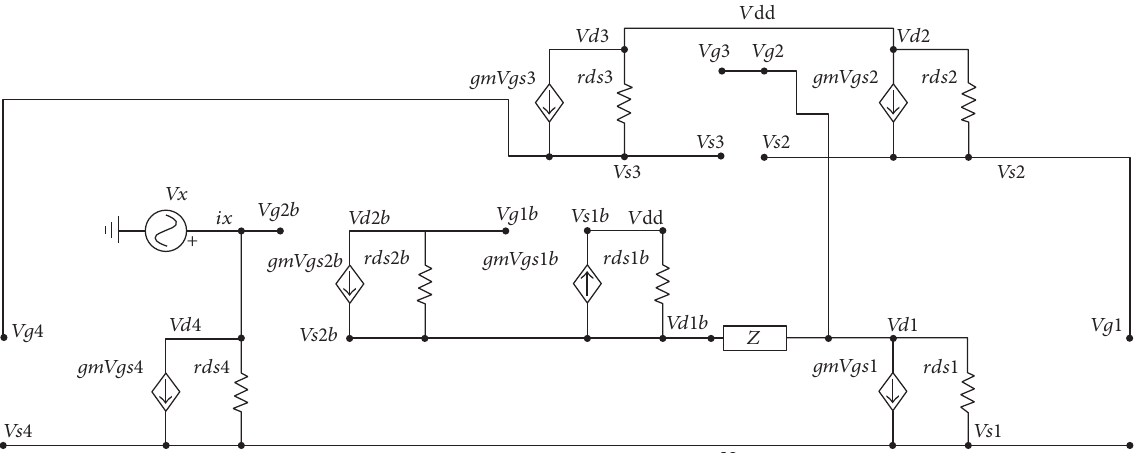
Figure 7: Small signal equivalent circuit of the proposed 𝐶 -multiplier.